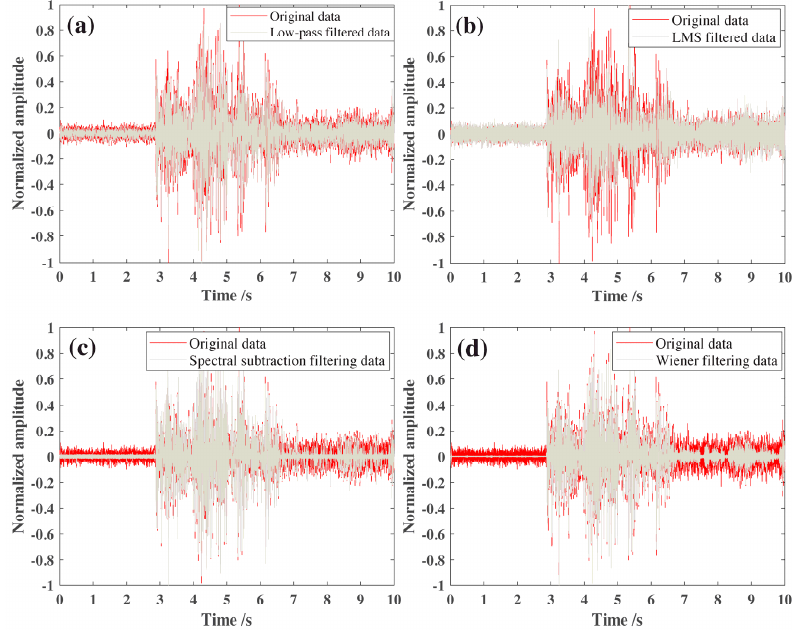
Figure 6. ( a ) Comparison of waveforms between the original signal and that filtered using ( a ) a low-pass filter, ( b ) a LMS filter, ( c ) a spectral subtraction filter, and ( d ) a Wiener filter. Remote Sens. 2023 , 15 , x FOR PEER REVIEW In order to understand the effects of the filtering effect more intuitively, the acoustic spectrograms are plotted in Figure 7. It is seen that the low-pass filter filters the high- frequency harmonic part above 200 Hz (Figure 7b). If using a LMS adaptive filter (Figure 7c), the noise is reduced, but there is still white Gaussian noise in the high-frequency part. This is because white Gaussian noise with a signal-to-noise ratio of 5 dB was added before using the LMS filter. By comparing Figure 7a,d, it can be seen that when using the spectral subtraction filter, the non-thunder signal is reduced, especially in the first 2 s, while the noise in the frequency range of 400–800 Hz is enhanced during the thunder. By comparing Figure 7a,e, it is seen that Wiener filtering is effective in noise removal. Signals above 400 Hz are filtered by Wiener filtering, which has no effect on the signals below 200 Hz and does not cause signal distortion. In addition, the non-thunder signal in the first 2 s is well removed. However, the low-frequency noise is amplified by the Wiener filter, such as the signals after 7 s in Figure 7e, and this may cause biases in thunder recognition.